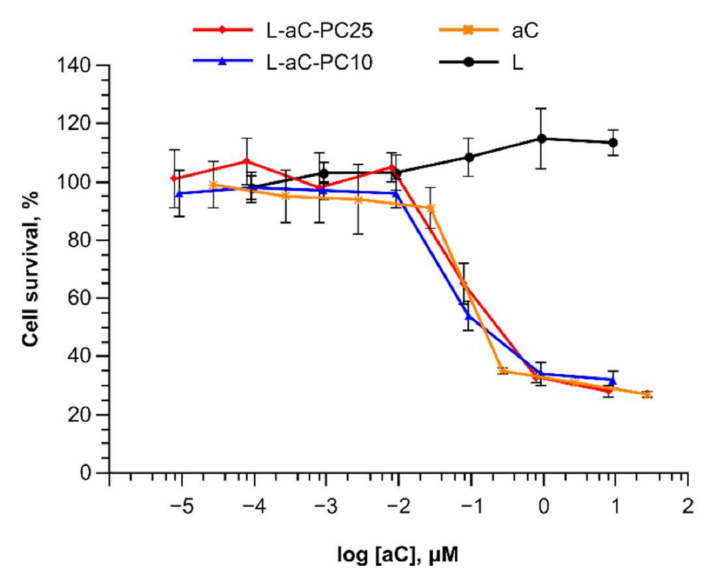
Figure 7. Cytotoxic activity of aC-PC liposomes against glioblastoma cells. L-aC-PC10, blue; L-aC- PC25, red; aC, orange; L, black. Mean ± SE are reported. n =